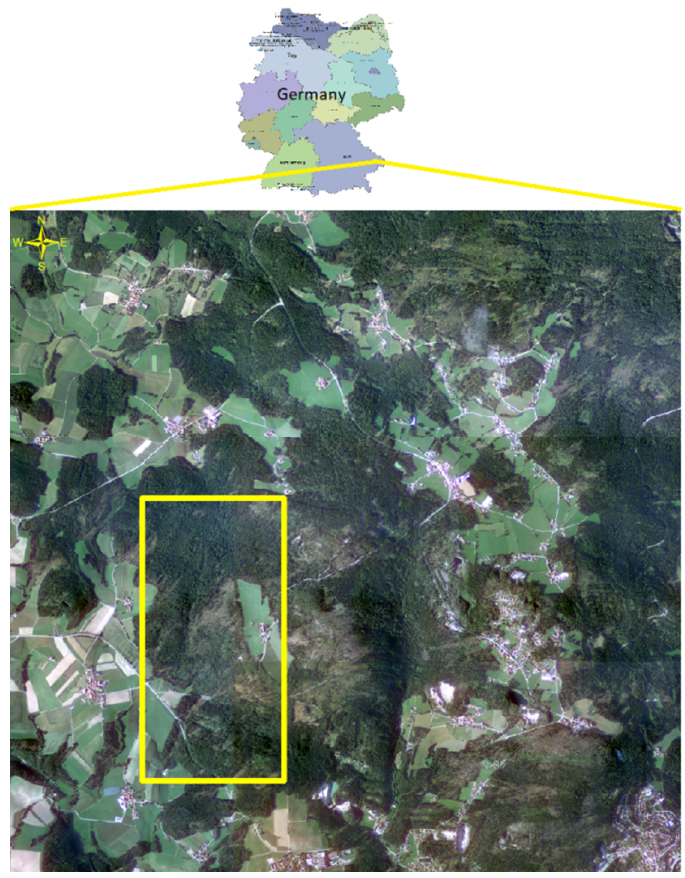
Figure 1. A 6 × 6 km clip from an aerial photo campaign in the growth region of the Bavarian Forest. On the lower right side, the city of Hauzenberg is shown. Pictures were taken at the end of August 2017. The yellow rectangle, measuring 3 × 1.5 km, represents the training region for the algorithms. Validation was done for the whole area (training region excluded). Table 1. Coordinates of clipped region and training